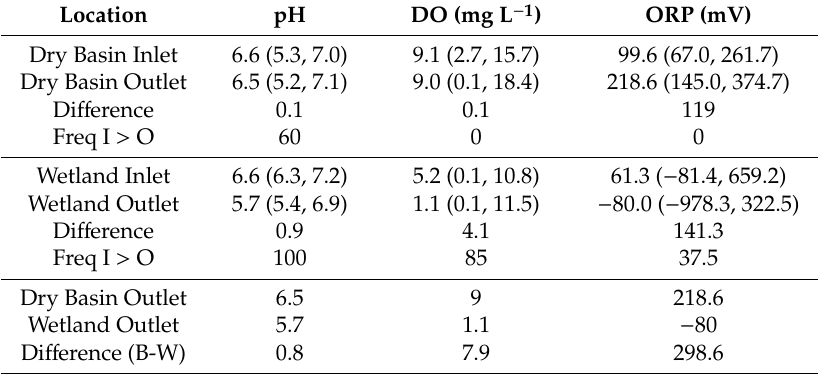
Table 1. Median and range of physicochemical readings for the inlet and outlet of the dry detention basin and wetland. Frequencies that the inlet (I) values exceeded the outlet values are